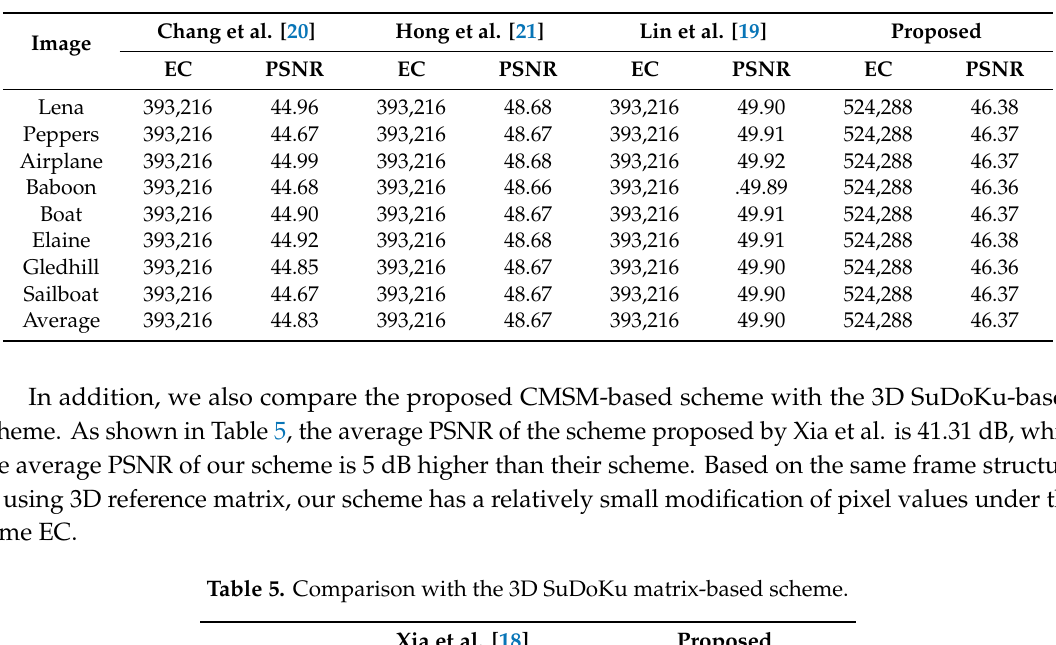
Table 4. Comparison among SuDoKu-based data-hiding schemes.